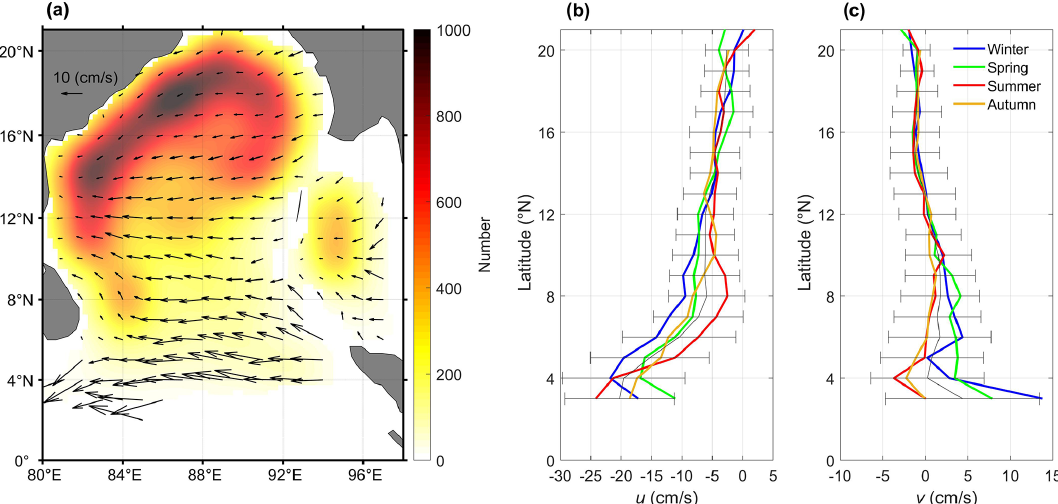
Figure 5. (a) Statistical eddy propagation speed (color indicates the numbers of eddy interiors for eddy trajectories with lifetimes ≥ 30d that passed through each 1 ◦ × 1 ◦ region) and (b) the zonal component u and (c) the meridional component v (thin solid line represents the mean value and its standard deviation, and the color represents the season) in the Bay of Bengal based on daily SLA fields spanning a 26-year period from January 1993 to February